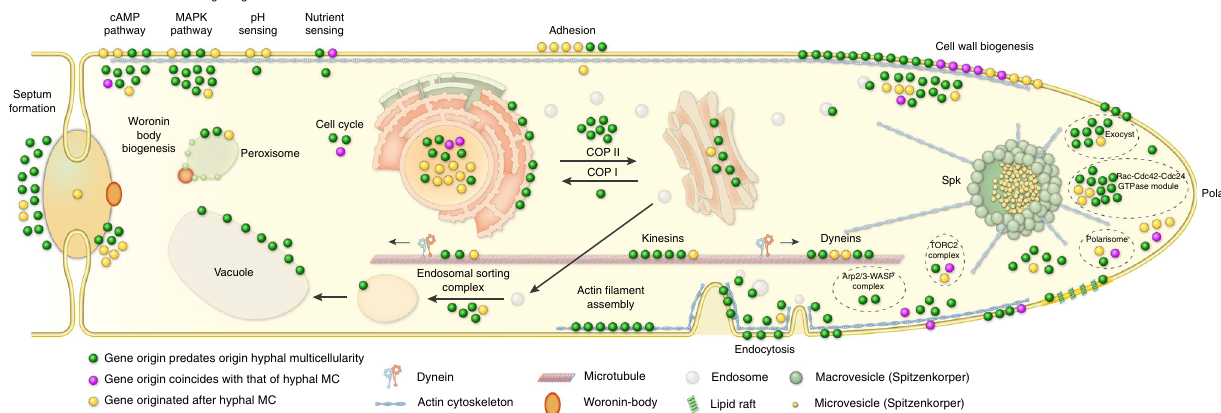
Fig. 3 Phylogenetic age distribution of hypha morphogenesis genes. Schematic outline of terminal hyphal cell is shown with genes marked by dots and colored by phylogenetic age. Genes whose origin (based on their containing gene family) predates that of hyphal multicellularity (green) dominate the hypha morphogenetic machinery, followed by genes that originated after hyphal MC (yellow) and genes whose origin approximately coincides with that of hyphae (purple). Data based on only A.fumigatus orthologs. See Supplementary Fig. 5 for